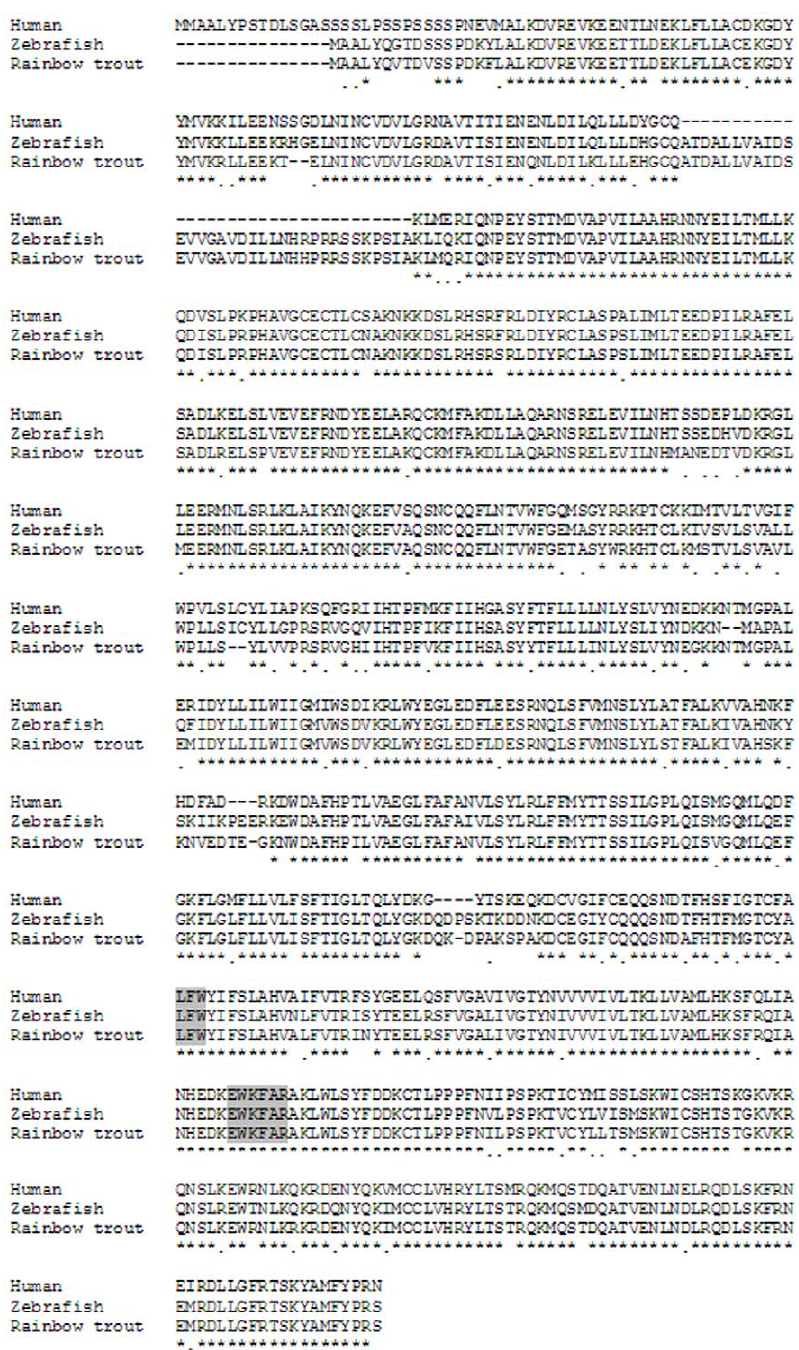
Figure 8. Sequence alignment of omTRPC1. Alignments of the omTRPC1 (accession number: GQ366701) sequence to known homologs in other species using the ClustalW algorithm. Conserved amino acids are denoted by *. The highly conserved channel pore domain (LFW) and TRP box (EWKFAR) are highlighted in gray.